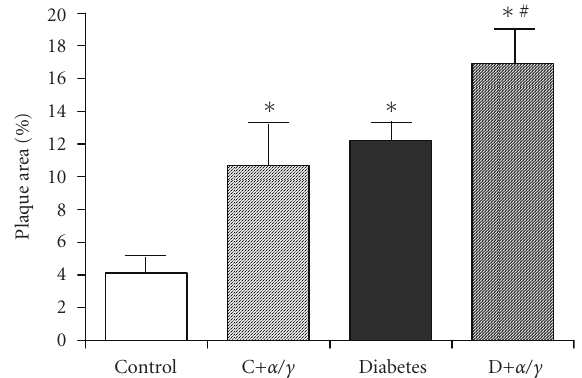
Figure 5: Total aortic plaque area as assessed by an en face approach in apoE knockout mice treated with the dual PPAR α / γ agonist, com- pound 3q for 20 weeks. P < .05 versus control